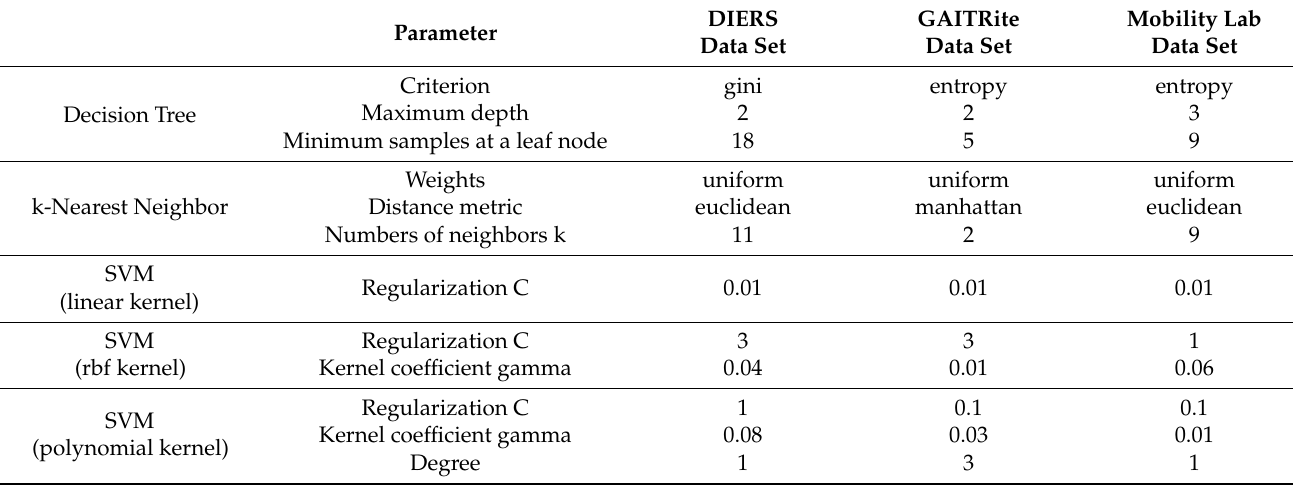
Table 4. Results of the hyperparameter optimization for each data set (matched collective); SVM = Support Vector Machine; rbf = radial basis